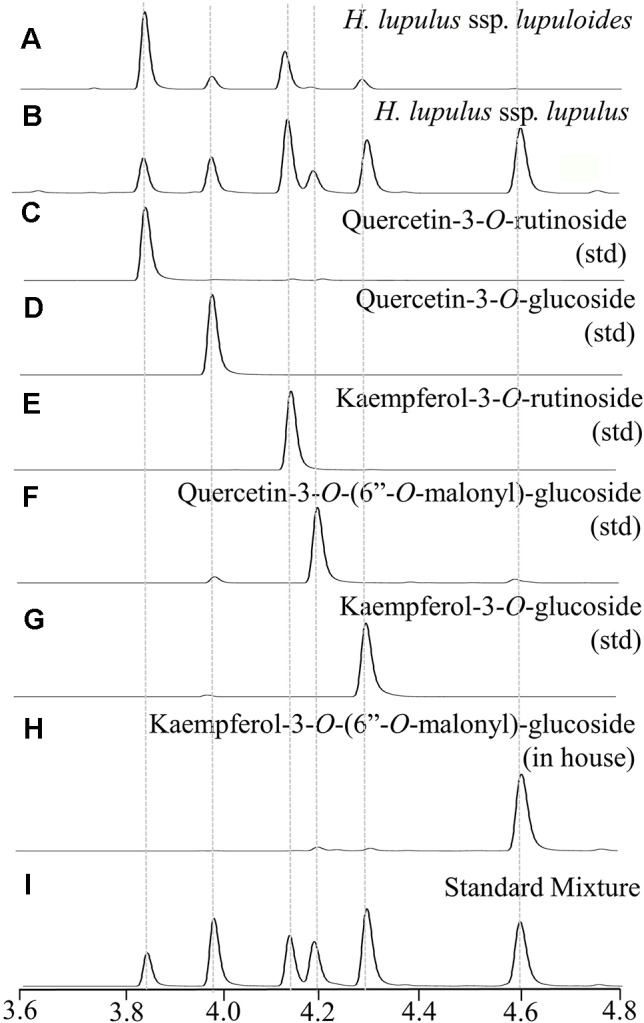
Representative UPLC-DAD chromatograms (350 nm) displaying hops leaf flavonol diversity showing: (A)
lupuloides low malonyl ester chemotype profile; (B)
lupulus high malonyl ester chemotype profile; (C–G) commercially sourced analytical standards (std); (H) in house purified peak; (I) reconstructed profile using mixture of standards.